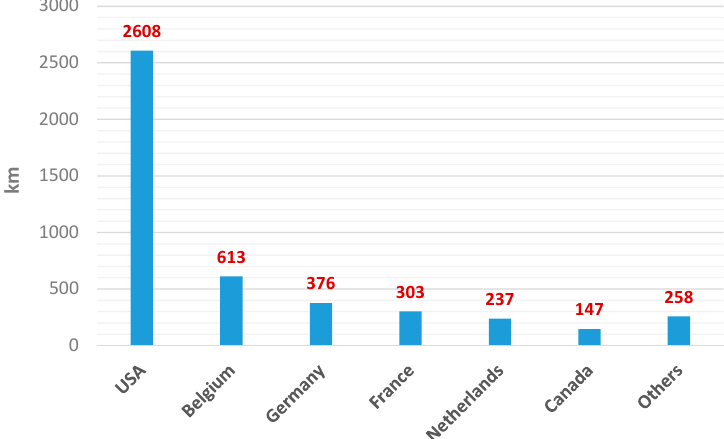
Figure 4. Global distribution of hydrogen pipelines (adapted from [57]).